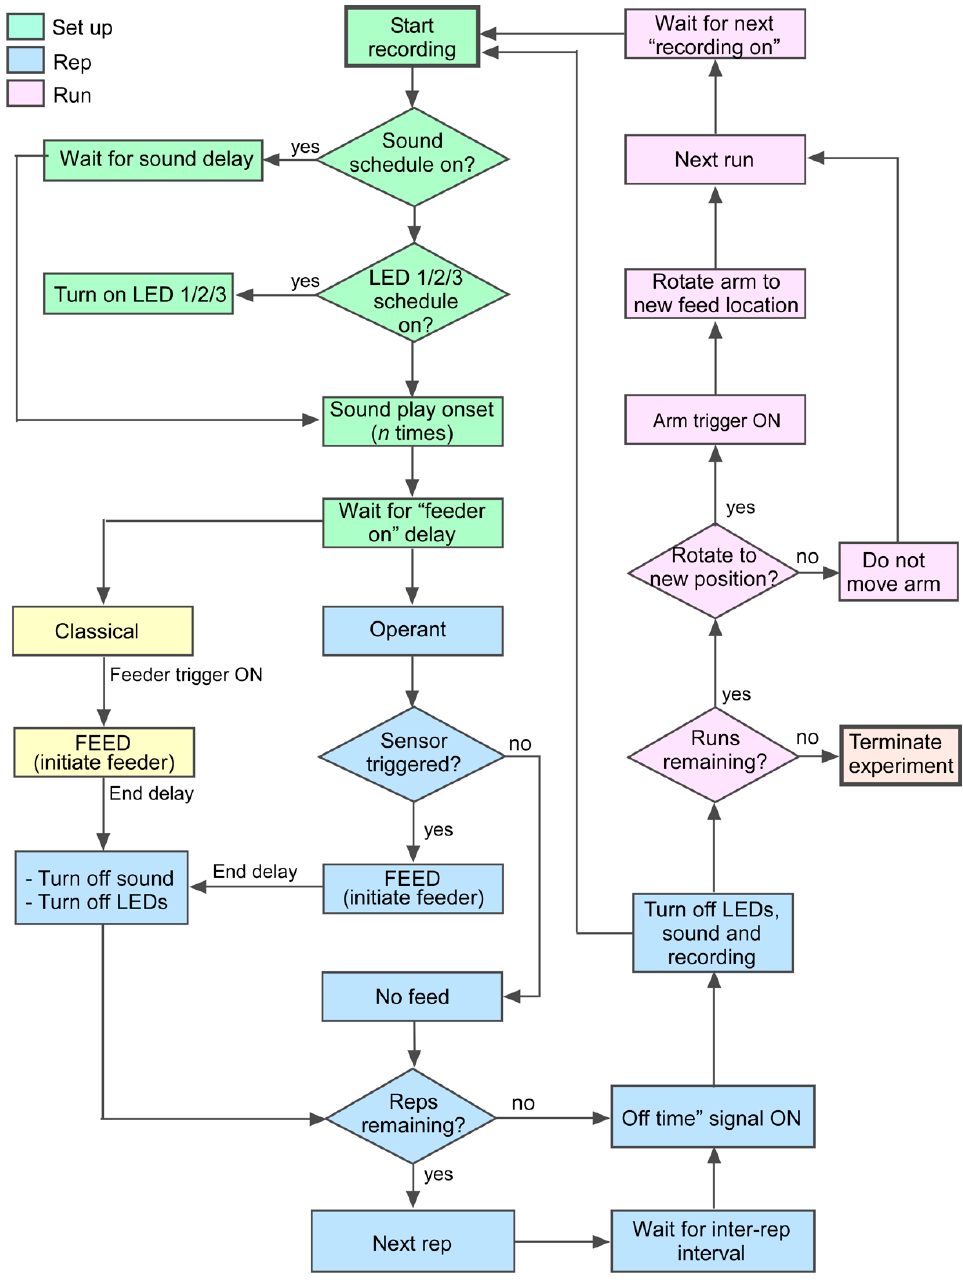
Figure 2. Flowchart depicting the algorithm for automated conditioning. The training procedure assigns user-defined delays for turning “on” and “off” light and sound or any other type of stimulus as part of the setup (green). Stimulus repetition (blue) provides multiple opportunities in close succession within each of multiple daily runs (pink) for the animal to learn the task.